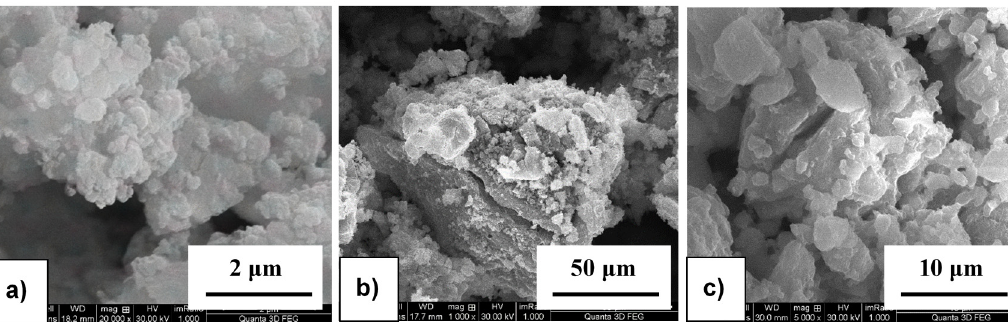
Figure 1. The morphology of as-received powders ( a ) LiAlH 4 and ( b ) CaCl 2 .